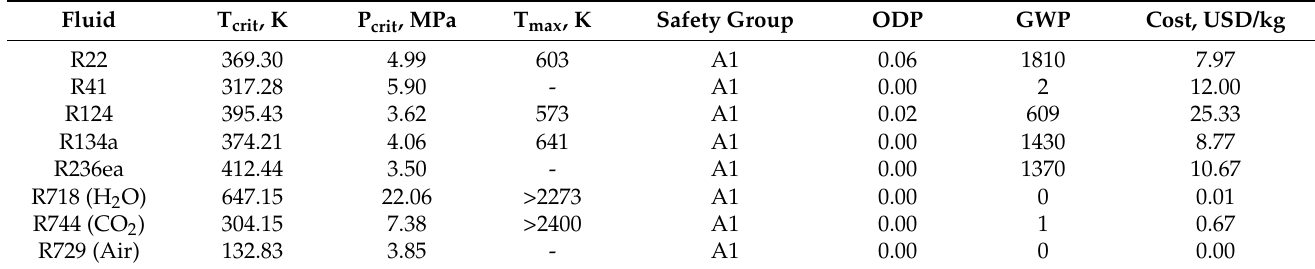
Table 4. Main parameters of selected working fluids for low temperature cycles.